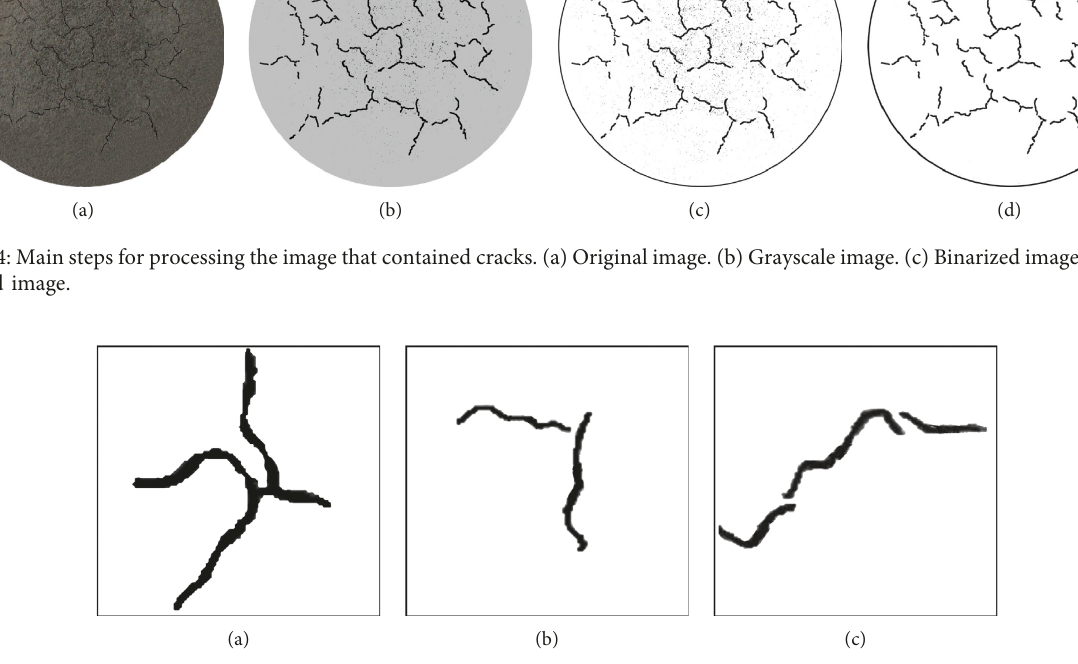
Figure 5: Determination of the crack number. (a) One crack. (b) Two cracks. (c) Three